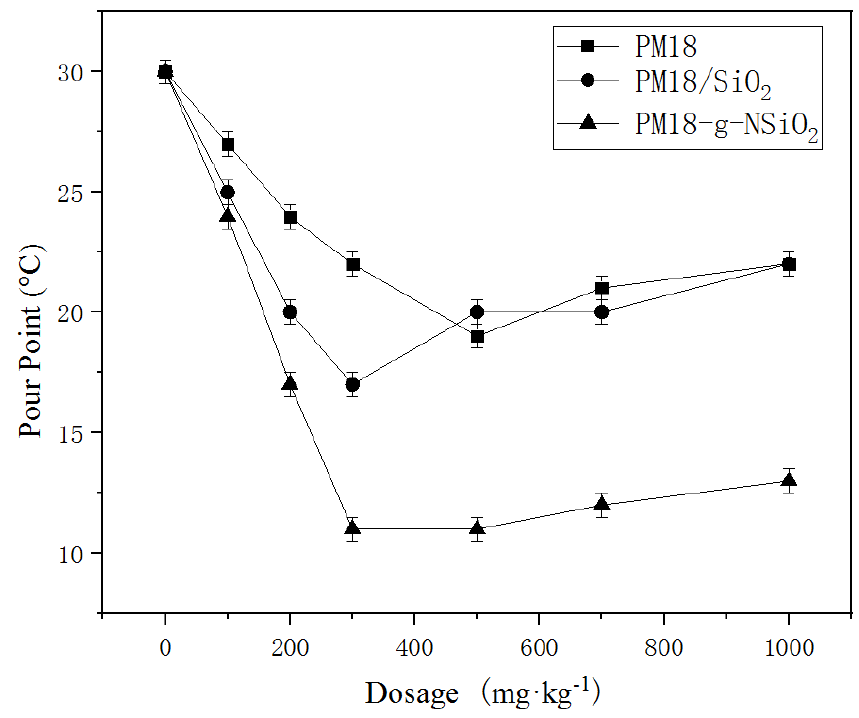
Figure 3. Pour point of 15 wt% model oil adding different kinds of NPPD.